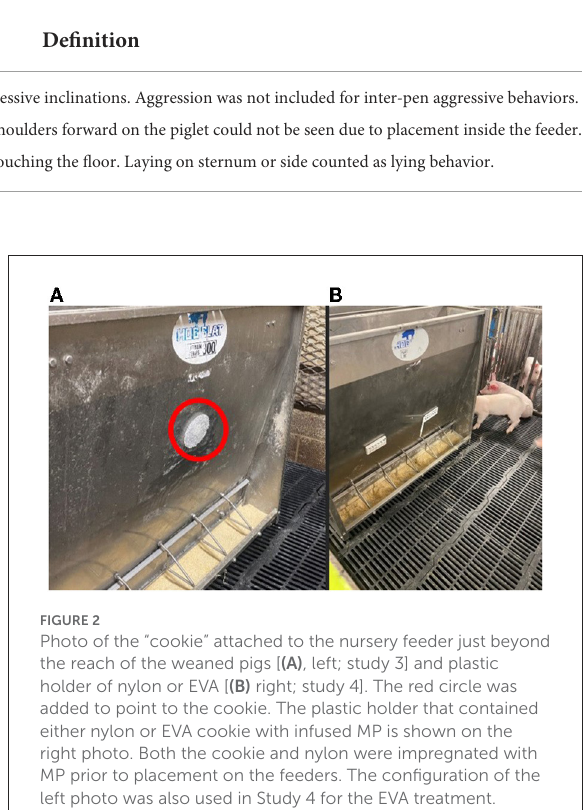
first 7 days post-weaning and the percentage of weaned pigs that lost body weight the first 7 days after